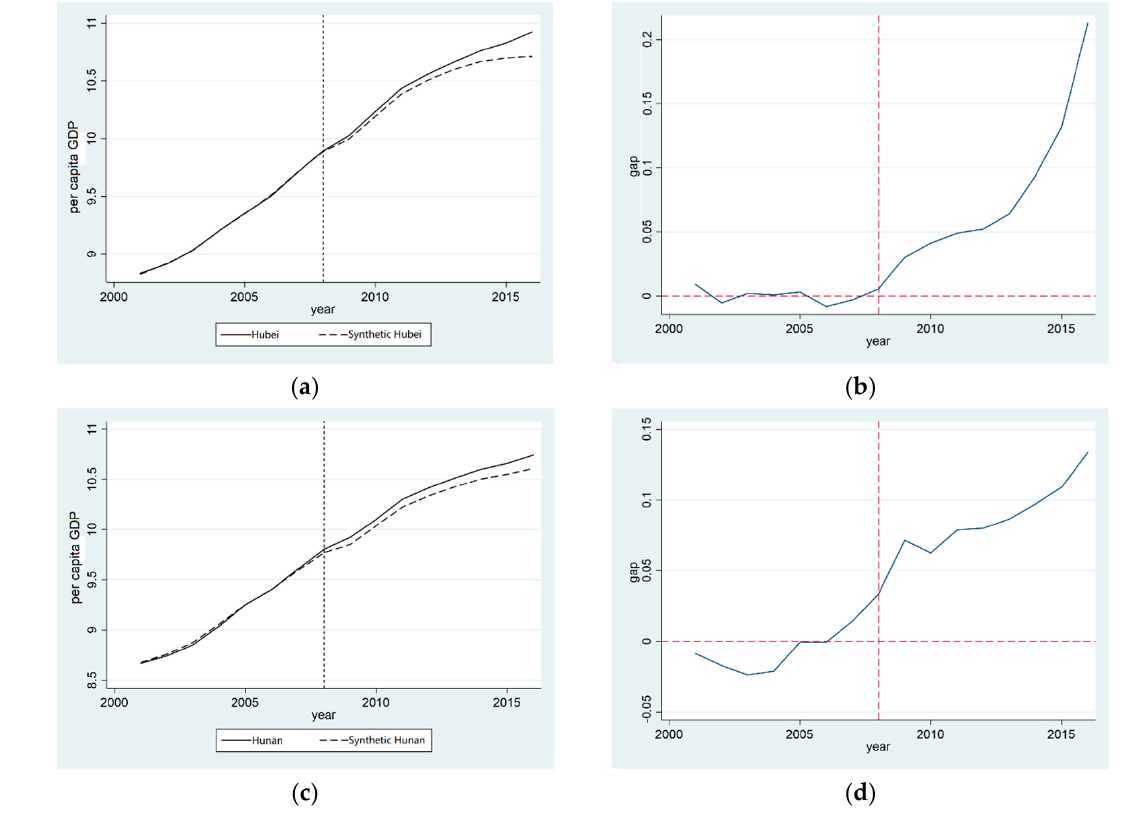
Figure 4. Comparison of GDP per capita reduction effect in provinces established in the “two-oriented society” pilot zone. ( a ) Policy effect of GDP per capita in Hubei; ( b ) Gap in GDP per capita in Hubei; ( c ) Policy effect of GDP per capita in Hunan; ( d ) Gap in GDP per capita in Hunan.